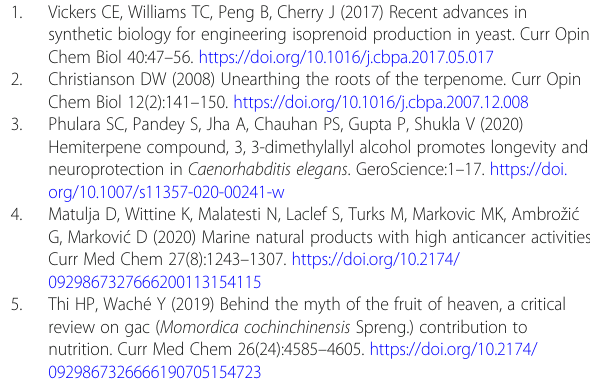
Additional file 1: Supplementary Table 1. List of sequences from plant, animal, protista, human, fungi, and